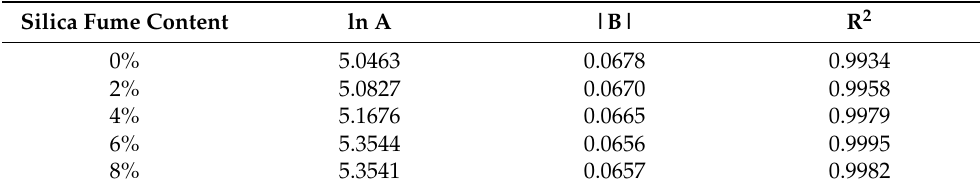
Table 6. Regression and correlation coefficients of silica fume/ styrene-butadiene-styrene composite- modified asphalt after